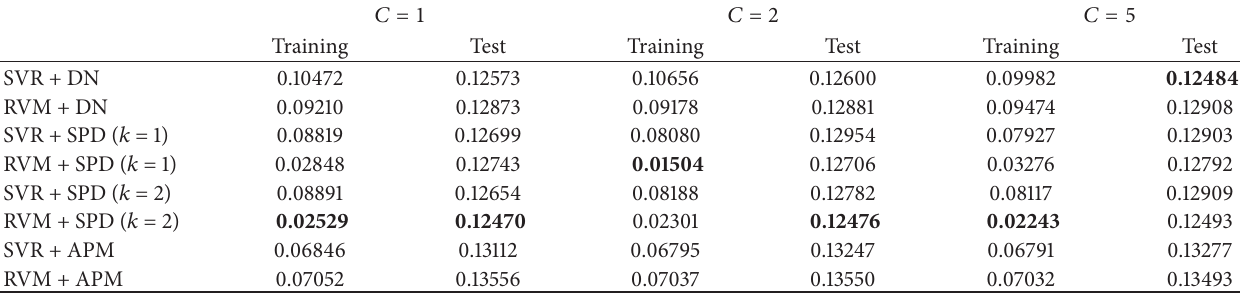
Table 1: Results of average RMSE for training and test